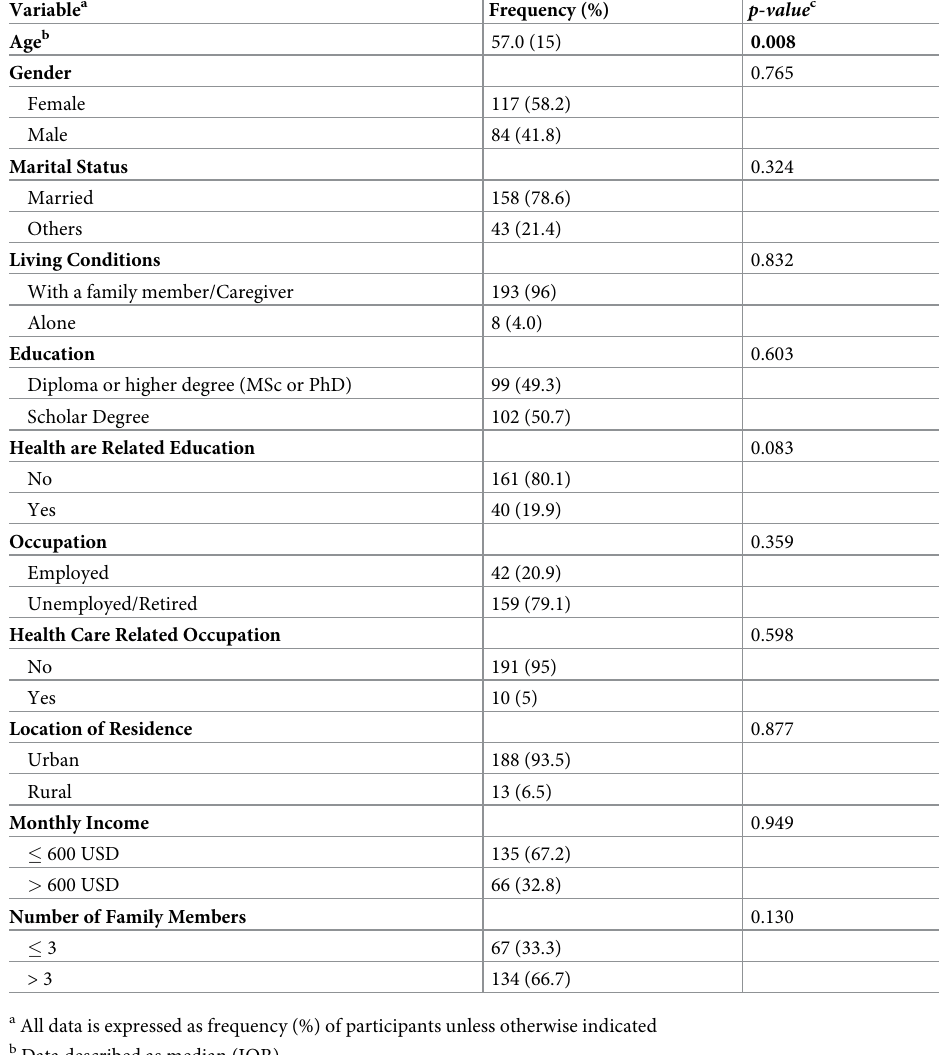
Table 1. Demographic characteristics of the study population (N =